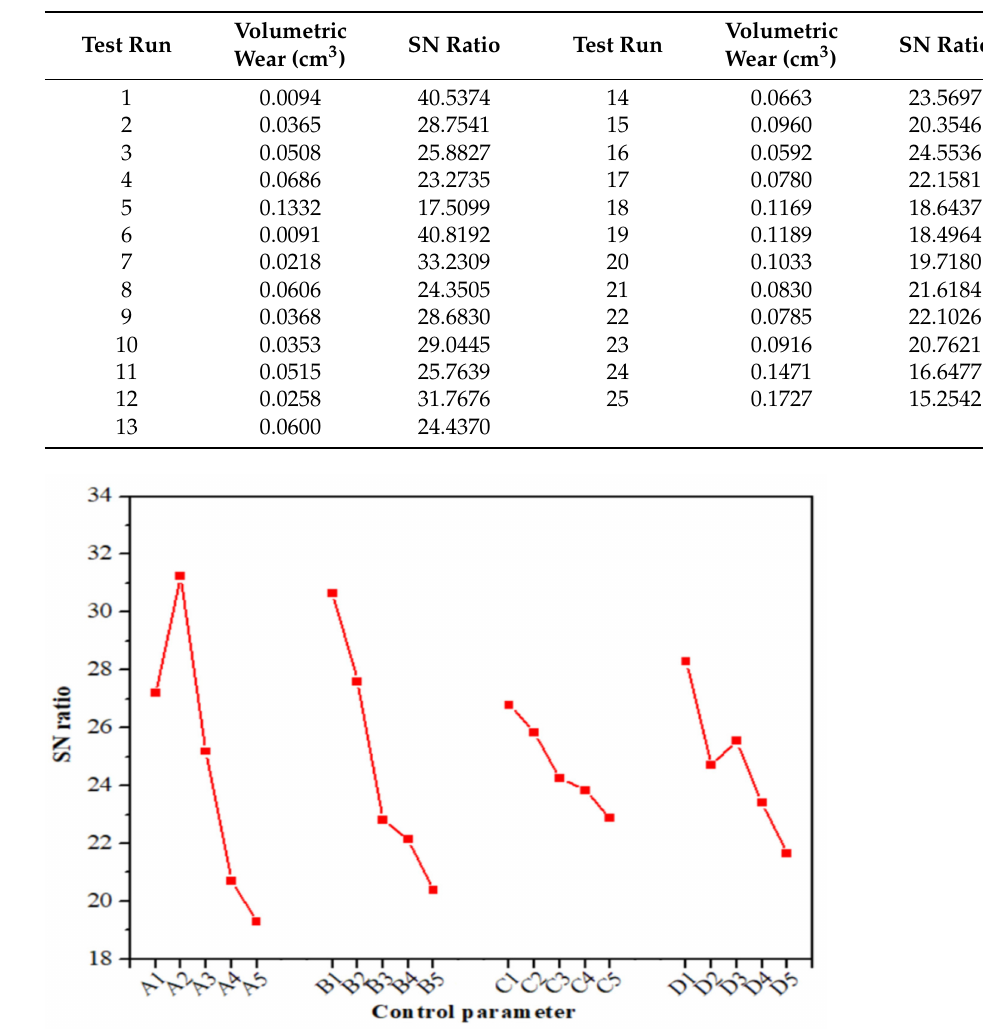
Table 4. Volumetric wear and corresponding SN ratio.